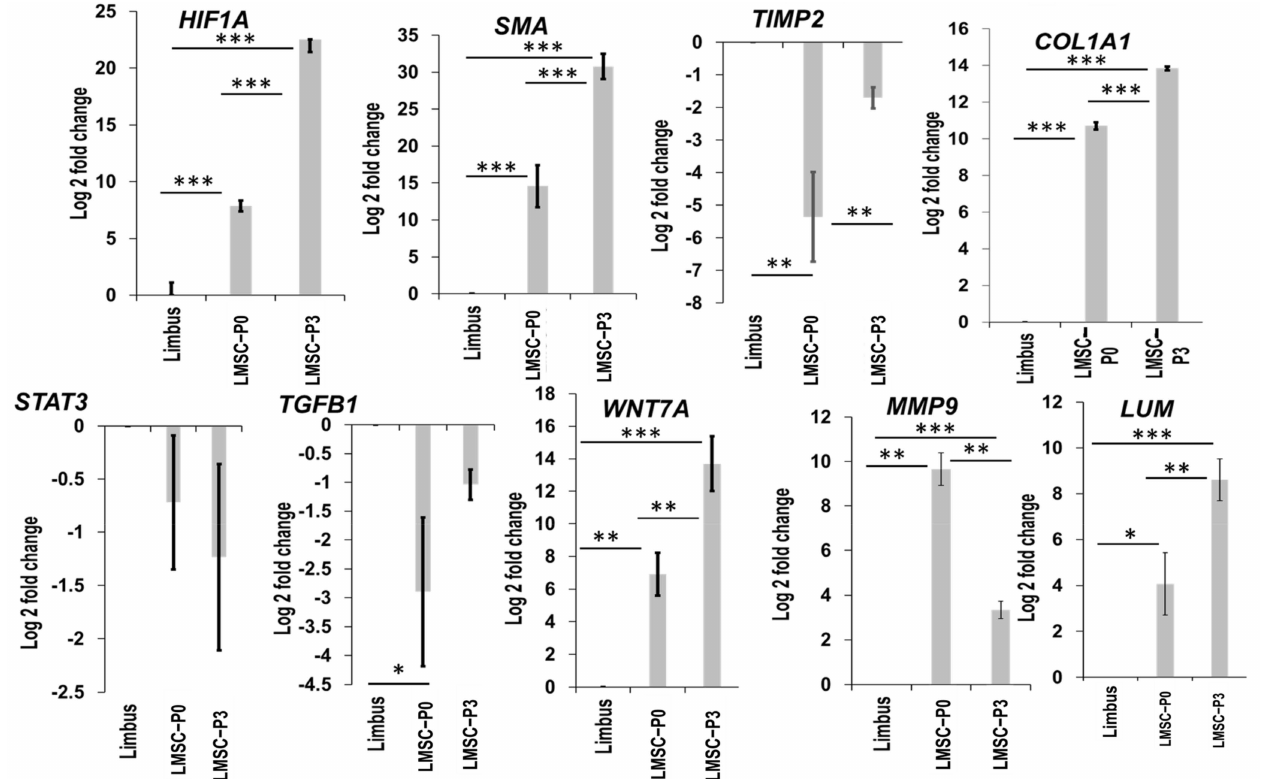
Figure 7. Validating the levels of DEGs. Level of expression of the differentially expressed genes vali- dated through qRT-PCR. The levels of DEGs in limbal epithelial (LMSC − P0) and stromal (LMSC − P3) cells was quantified relative to native limbal tissue ( n = 5). The results were plotted as mean log 2-fold change ± SD. The statistical analysis was performed using Kruskal–Wallis one-way ANOVA test. * p < 0.05, ** p < 0.01, *** p <